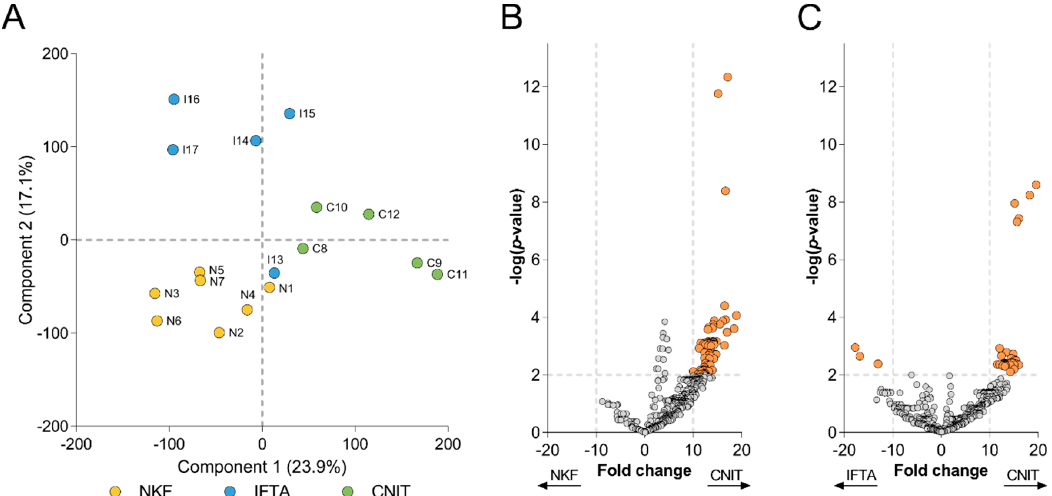
Figure 3. ( A ) Principal component analysis (PCA) biplot that shows distribution of samples according to Components 1 and 2. Each circle represents a sample, which are labelled and colored according to their group. Volcano plots depict the differentially expressed proteins ( B ) between CNIT and NKF, and ( C ) between CNIT and IFTA. Each circle represents a protein. On y-axis − log( p -value) from a t-test is represented, with a dashed line at p < 0.01 to indicate significance, over which proteins are colored in orange. The expression fold change is represented on the x-axis, with dashed lines at > 10 and < − 10.